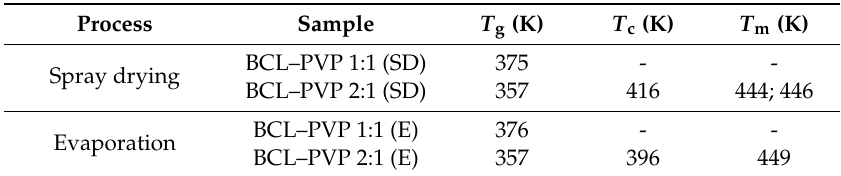
Table 1. Comparison of the glass transition temperature ( T g ), T c and T m values of binary systems containing BCL and